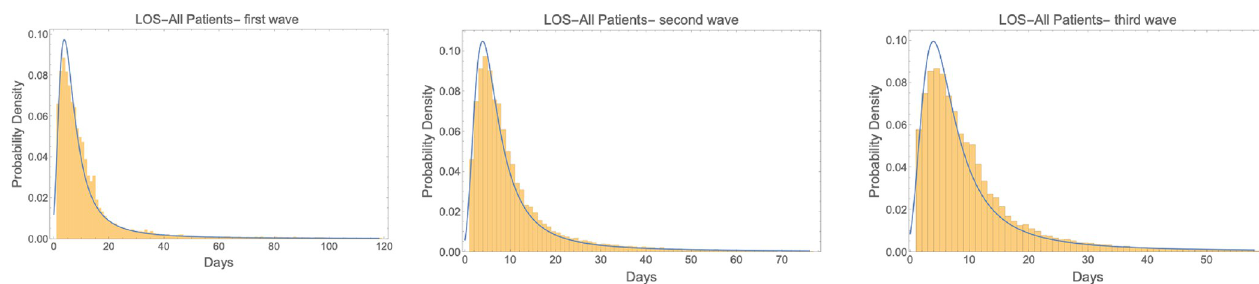
Fig 3. LOS for all hospitalizations in three waves in Gauteng, SA.